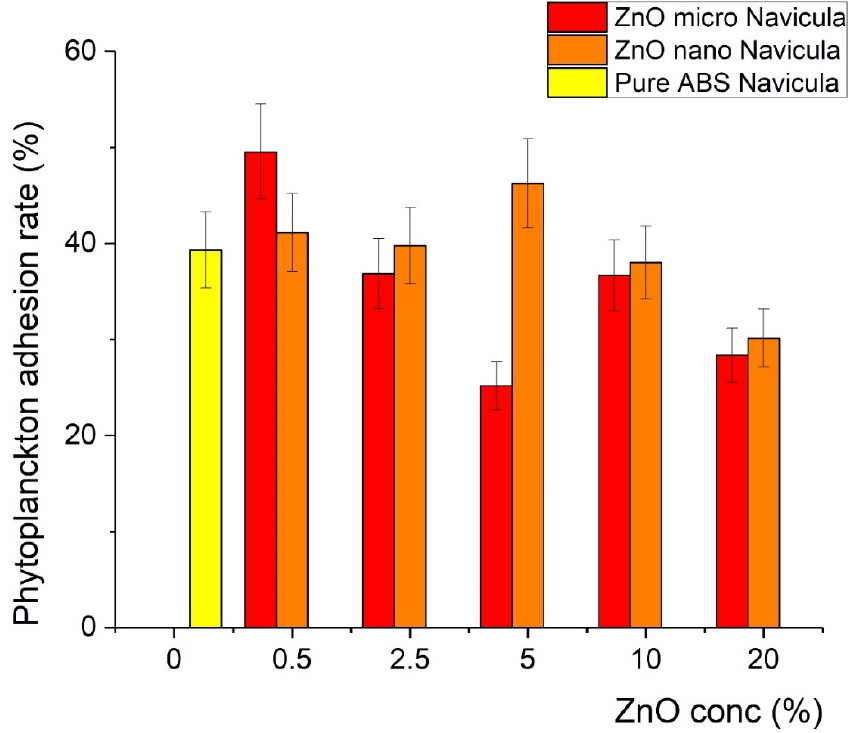
Figure 10. Percentage of coverage of composite material with Navicula.